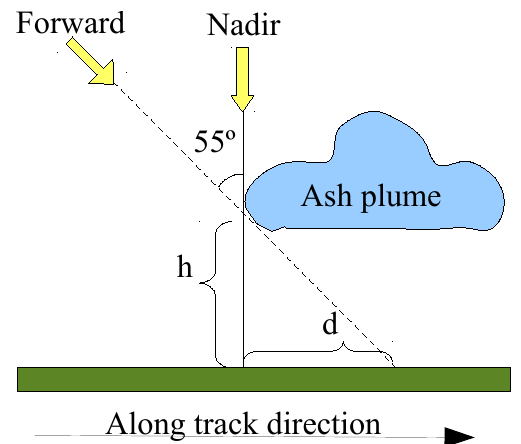
Figure 1. Cloud height estimate geometry. The edge of the cloud (at altitude h ) is observed at different apparent positions at ground level in the two views, with distance d . With increasing height the distance